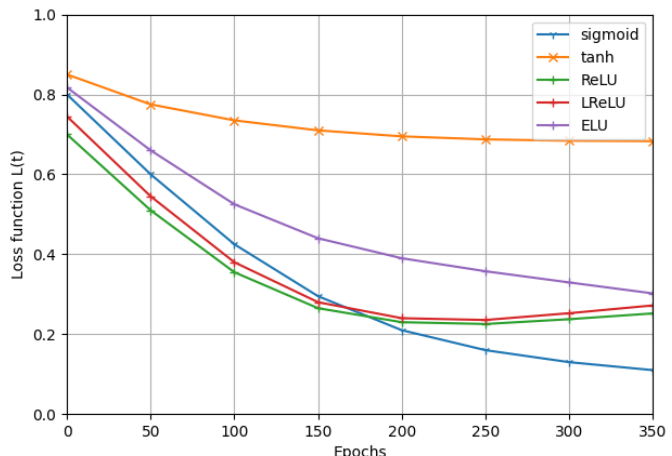
Figure 12. Loss function versus number of epochs for the proposed CNN-based SIC scheme with varying activation functions.